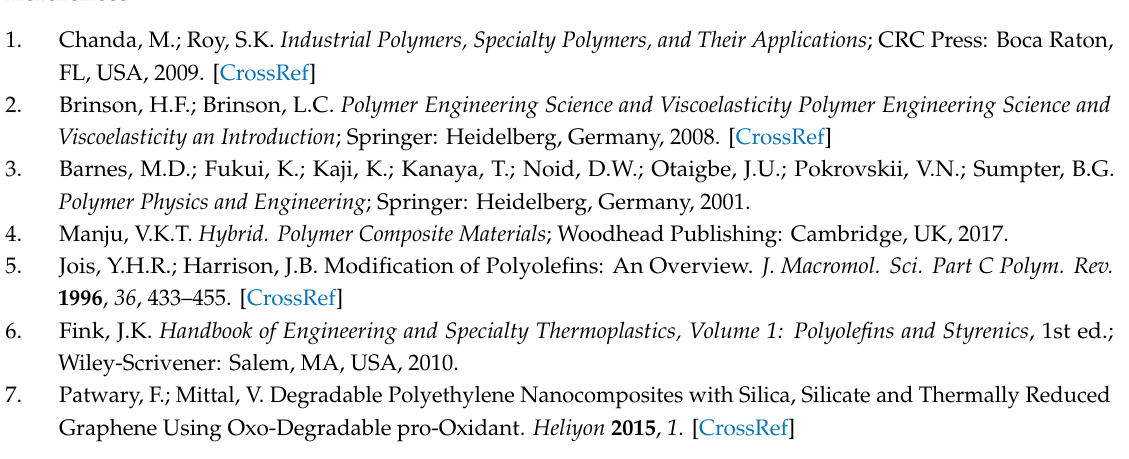
Table S1: List of isolated compounds; Table S2. Crystallinity indices (CI) of the obtained composites; Table S3. Heat Deflection Temperatures of the obtained composites; Figure S1: 1 H NMR of SSQ-8Cl; Figure S2: 13 C NMR of SSQ-8Cl; Figure S3: 29 Si NMR of SSQ-8Cl; Figure S4: 1 H NMR of iBu 7 SSQ-Cl; Figure S5: 13 C NMR of iBu 7 SSQ-Cl; Figure S6: 29 Si NMR of iBu 7 SSQ-Cl; Figure S7: 1 H NMR of iBu 7 SSQ-NH 2 ; Figure S8: 13 C NMR of iBu 7 SSQ-NH 2 ; Figure S9: 29 Si NMR of iBu 7 SSQ-NH 2 ; Figure S10: 1 H NMR of iBu 7 SSQ-Vi; Figure S11: 13 C NMR of iBu 7 SSQ-Vi; Figure S12: 29 Si NMR of iBu7SSQ-Vi; Figure S13: 1 H NMR of iBu 7 SSQ-3OH; Figure S14: 13 C NMR of iBu 29 Si NMR of iBu 7 SSQ-3OH; Figure S15: 7 SSQ-3OH; Figure S16: MALDI-TOF-MS spectrogram of iBu 7 SSQ-3OH heat treatment products; Figure S17: MALDI-TOF-MS spectrogram of iBu 7 SSQ-3OH heat treatment products (enhanced); Figure S18: 0.1% SSQ-8Cl / PE; Figure S19: 0.5% SSQ-8Cl / PE; Figure S20: 1% SSQ-8Cl / PE; Figure S21: 0.1% iBu7-SSQ-Cl / PE; Figure S22: 0.5% iBu 7 -SSQ-Cl / PE; Figure S23: 1% iBu 7 -SSQ-Cl / PE; Figure S24: 0.1% iBu 7 -SSQ-NH2 / PE; Figure S25: 0.5% iBu 7 -SSQ-NH2 / PE; Figure S26: 1% iBu 7 -SSQ-NH2 / PE; Figure S27: 0.5% iBu 7 -SSQ-Vi / PE; Figure S28: 1% iBu 7 -SSQ-Vi / PE; Figure S29: 1.5% iBu 7 -SSQ-Vi / PE; Figure S30: 0.5% iBu 7 -SSQ-3OH / PE; Figure S31: 0.5% iBu 7 -SSQ-3OH / PE (higher magnification); Figure S32: 1% iBu 7 -SSQ-3OH / PE; Figure S33: 1% iBu 7 -SSQ-3OH (higher magnification); Figure S34: 1.5% iBu 7 -SSQ-3OH; Figure S35: 1.5% iBu 7 -SSQ-3OH (higher